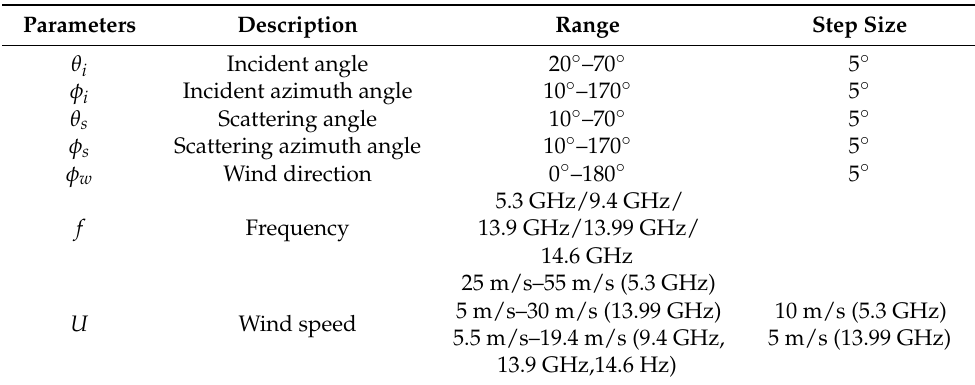
Table 1. The ranges of the incidence and received angle, operating frequencies, and sea wind speeds in the DOA estimation experiment.